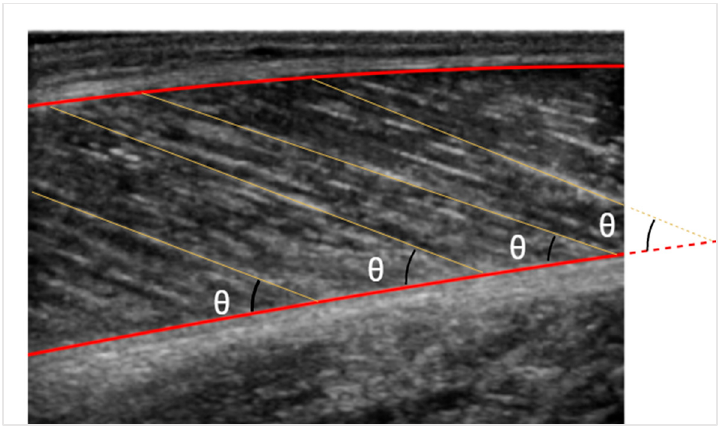
Figure 6. Pennation angle is depicted with θ . The fascicle length is illustrated with yellow lines.